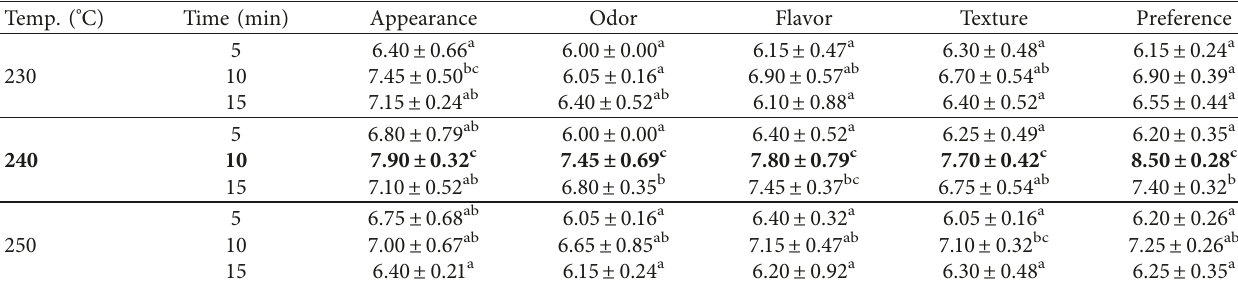
Table 2: Sensory evaluation of steam oven-treated